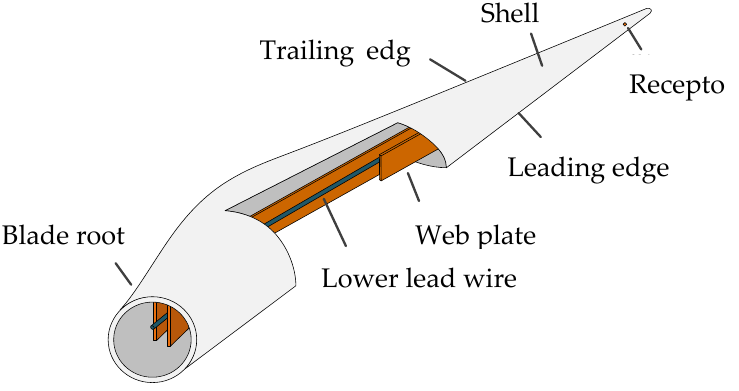
Figure 2. Lightning protection system recommended by IEC/TR 61400-24.